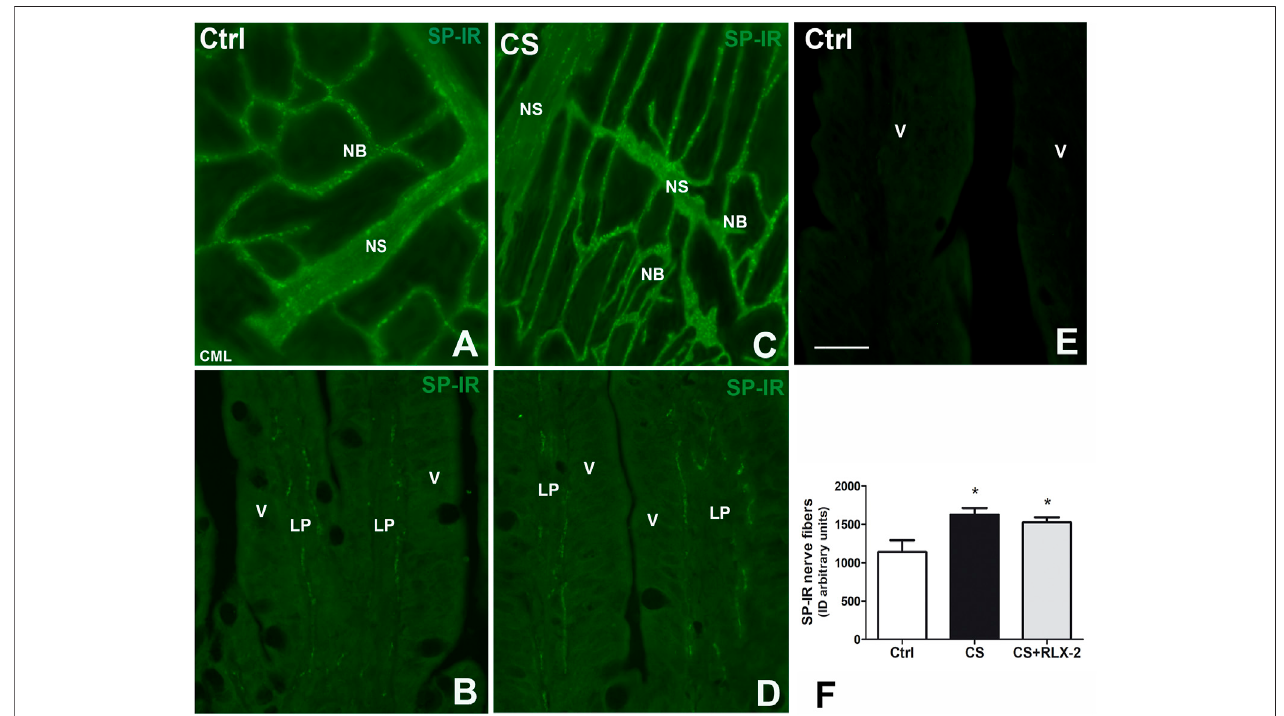
FIGURE 6 | Increase in substance P (SP)-immunoreactive (IR) nerve fi bers in the submucosa and the mucosa in the ileum of the cigarette smoke (CS) group and effects of relaxin-2 (RLX-2). (A, C) Laminae, submucosa. SP-IR was located in numerous nerve fi bers forming nerve bundles ( NB ) and in the nerve strands ( NS ). (B – E) Full-thickness section, mucosa. Thin SP-IR nerve fi bers ran along the axes of the villi ( V ) mostly lining the epithelium ( E ). (E) Negative control. (F) SP-IR nerve fi bers signi fi cantly increased in the mucosa and submucosa of CS-exposed animals. This increase was insensitive to RLX-2 treatment. CML , circular muscle layer; LP , lamina propria. Bar , 50 μ m (A – E) . * p < 0.05.